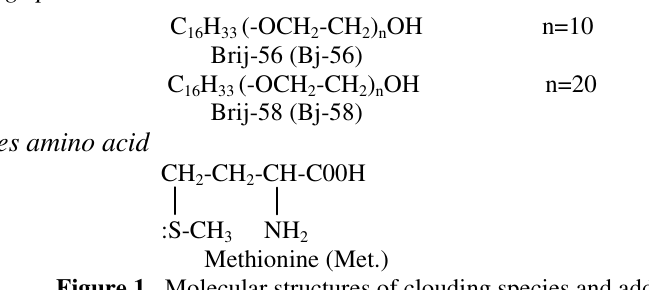
Figure 1. Molecular structures of clouding species and